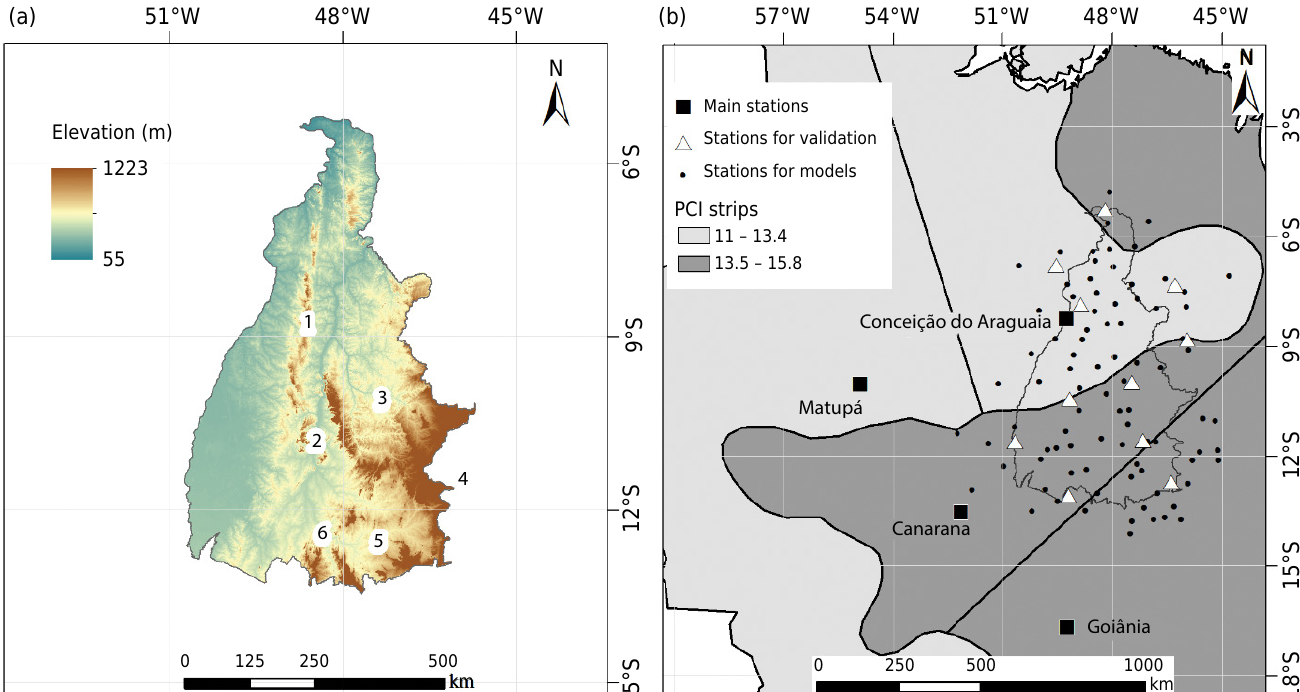
Figure 1. Digital Elevation Model, highlighting the location of Serra do Estrondo (1) , Serra das Cordilheiras (2), Serra do Lajeado (3), Serra Geral de Goiás (4), Serra das Traíras (5), and Serra da Bocaina (6) (a); and distribution of pluviometric posts for modeling and validation, locations with equations for the calculation of R-factor, and their respective areas of influence established by homogenous areas of rainfall concentration (ICP) and Thiessen’s polygons (b).